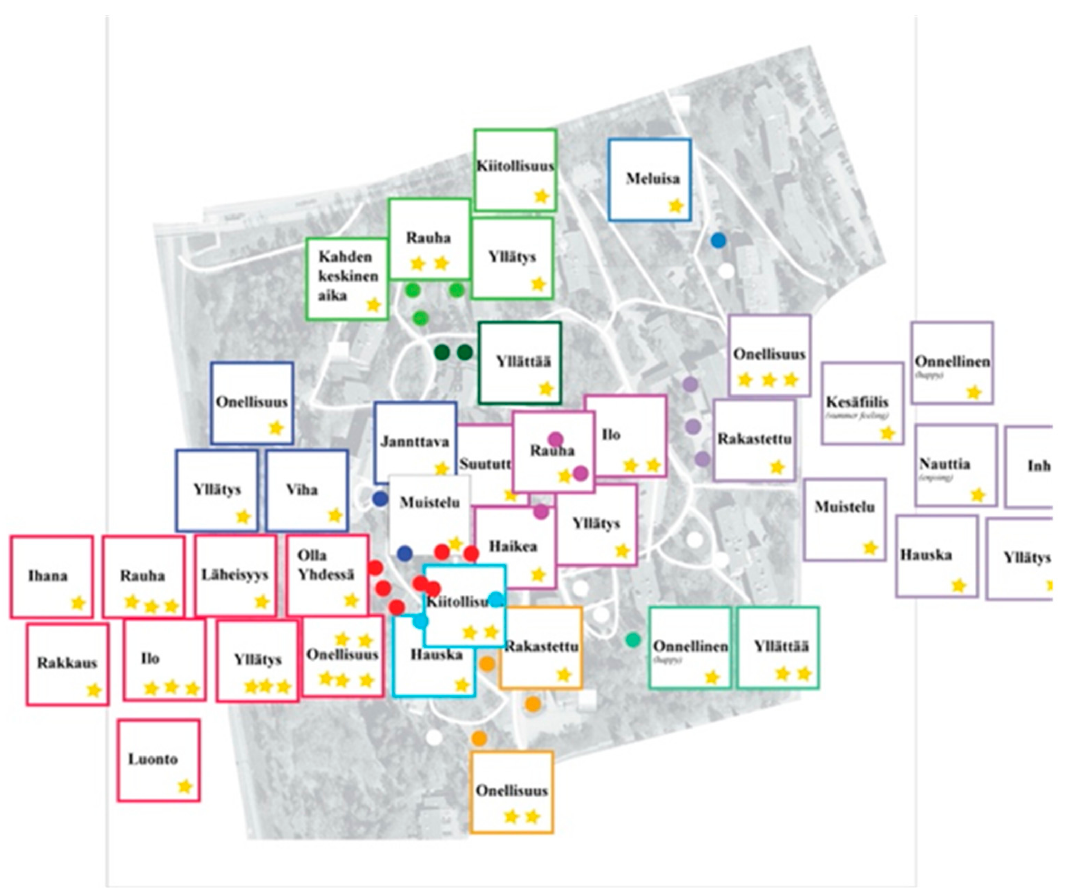
Figure 8. A visual summary of the emotions associated with the point of interest by the “Forest of Emotions” workshop participants.